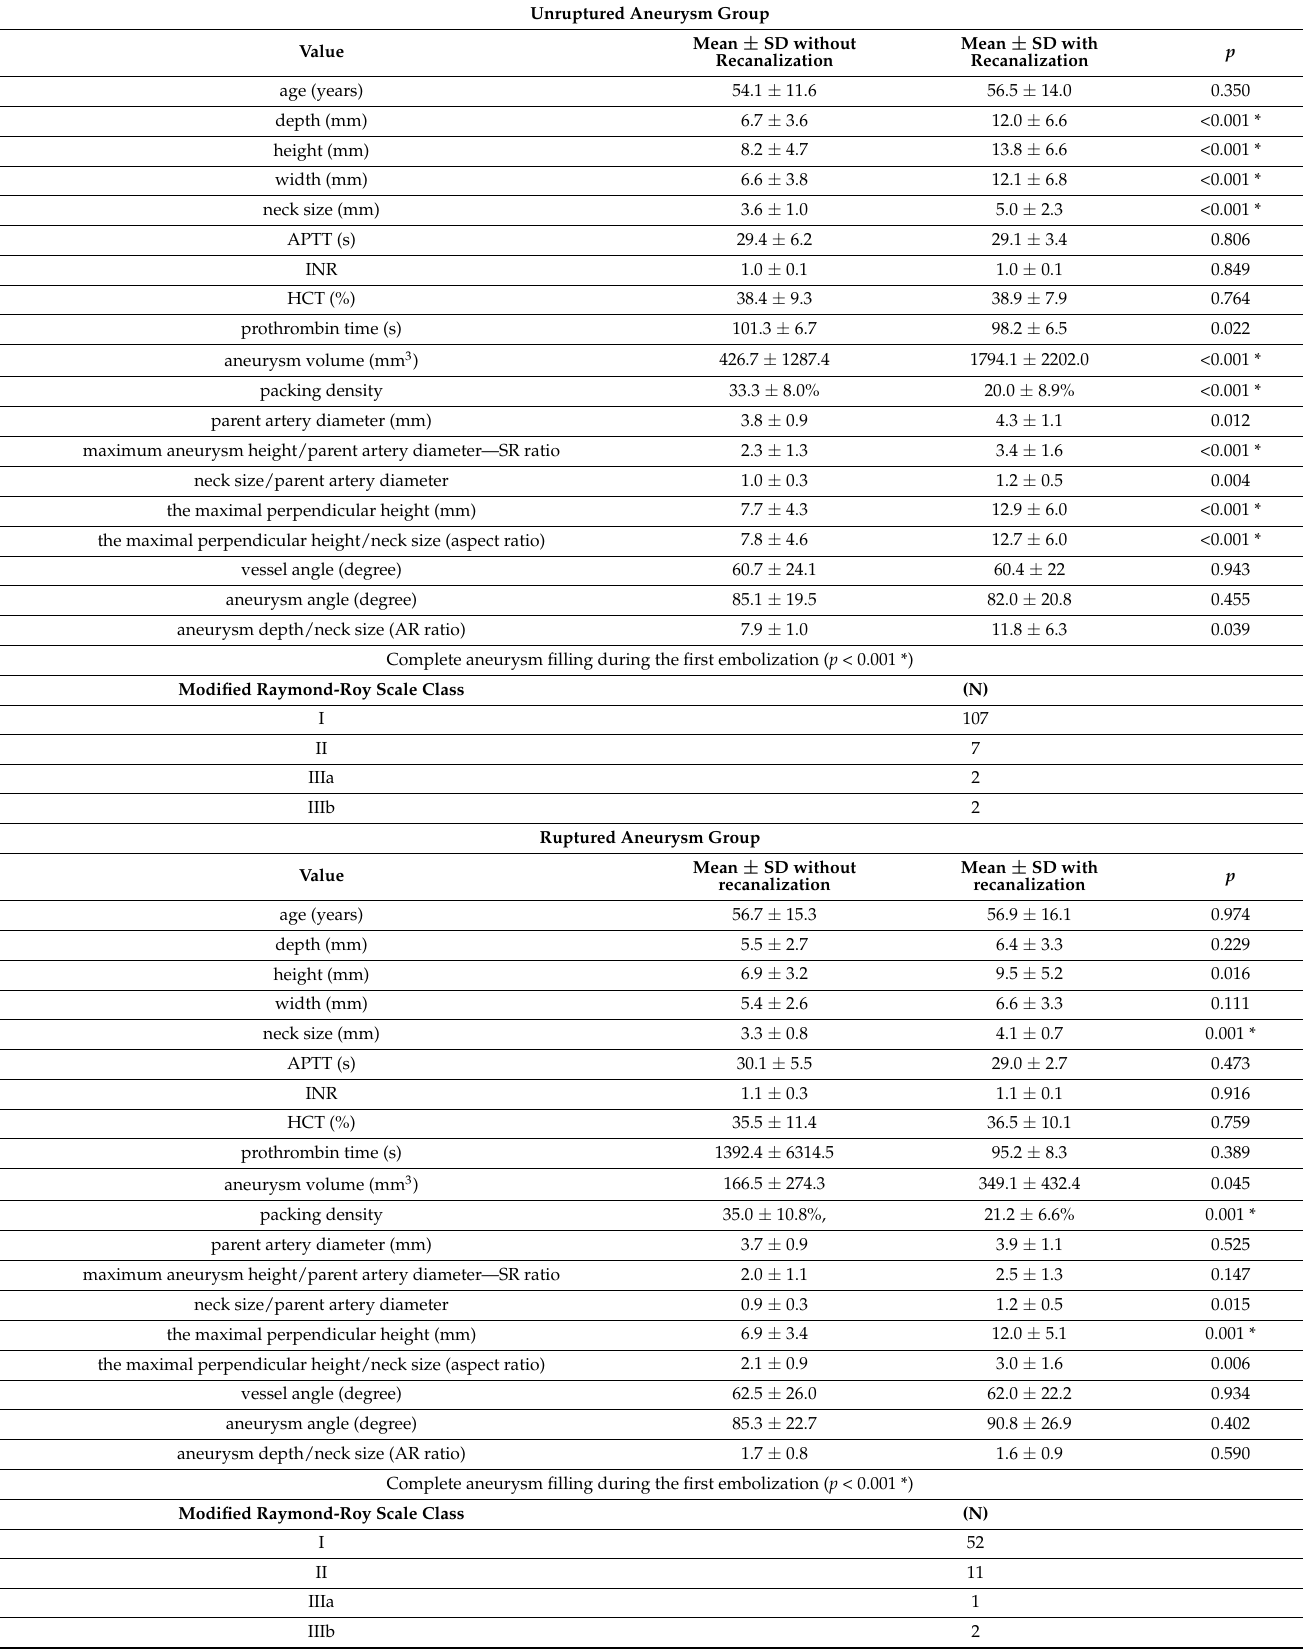
p values calculated using t -test; values marked with * remained significant after correction for multiple